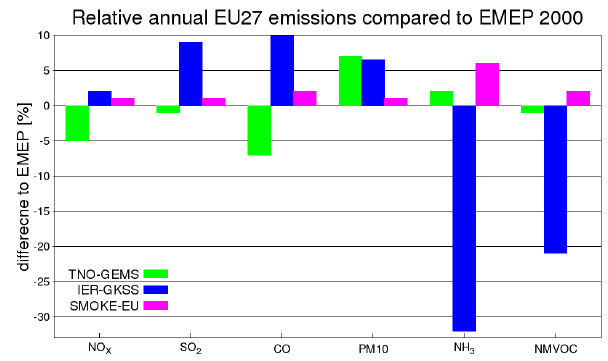
Fig. 4. Comparison of the annual total anthropogenic emissions of different emission datasets for the year 2000. Only emissions from the EU27 in the 54 × 54km 2 domain (Fig. 2) are taken into account. (The SMOKE-EU dataset also includes 18000Gga − 1 biogenic NMVOC emissions).